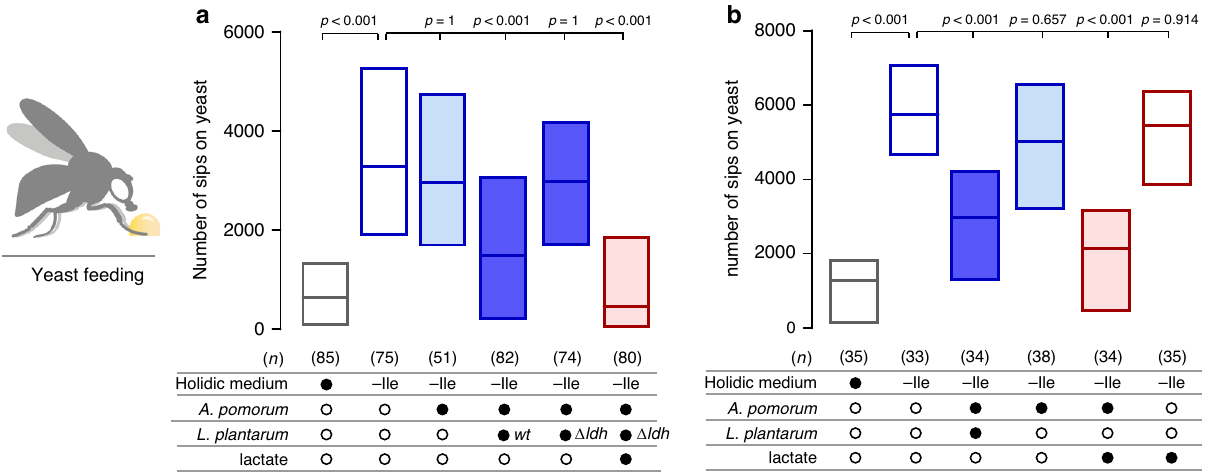
Fig. 4 Lactate production by Lp is necessary and suf fi cient to reduce yeast appetite in the presence of Ap . a , b Number of sips on yeast of either germ- free fl ies (empty boxes) kept in complete holidic medium (grey border boxes), or medium without Ile (-Ile, blue border boxes), or of fl ies that were monoassociated (light blue) with Ap , or biassociated (dark blue) with both Ap and Lp , or grown in medium containing lactate (burgundy). Filled black circles represent a complete holidic medium, or association with either Ap , wt or mutant Lp , or the presence of lactate in the medium. In a wt denotes the parental Lp WCFS1 strain and Δ ldh the deletion mutant Lp WCFS1 Δ ldh . Open black circles represent the absence of speci fi c bacteria or lactate. Boxes represent median with upper and lower quartiles. n represents the number of fl ies assayed per condition. Signi fi cance was tested using a Kruskal – Wallis test with Dunn ’ s multiple comparison test. Source data are provided as a Source Data fi